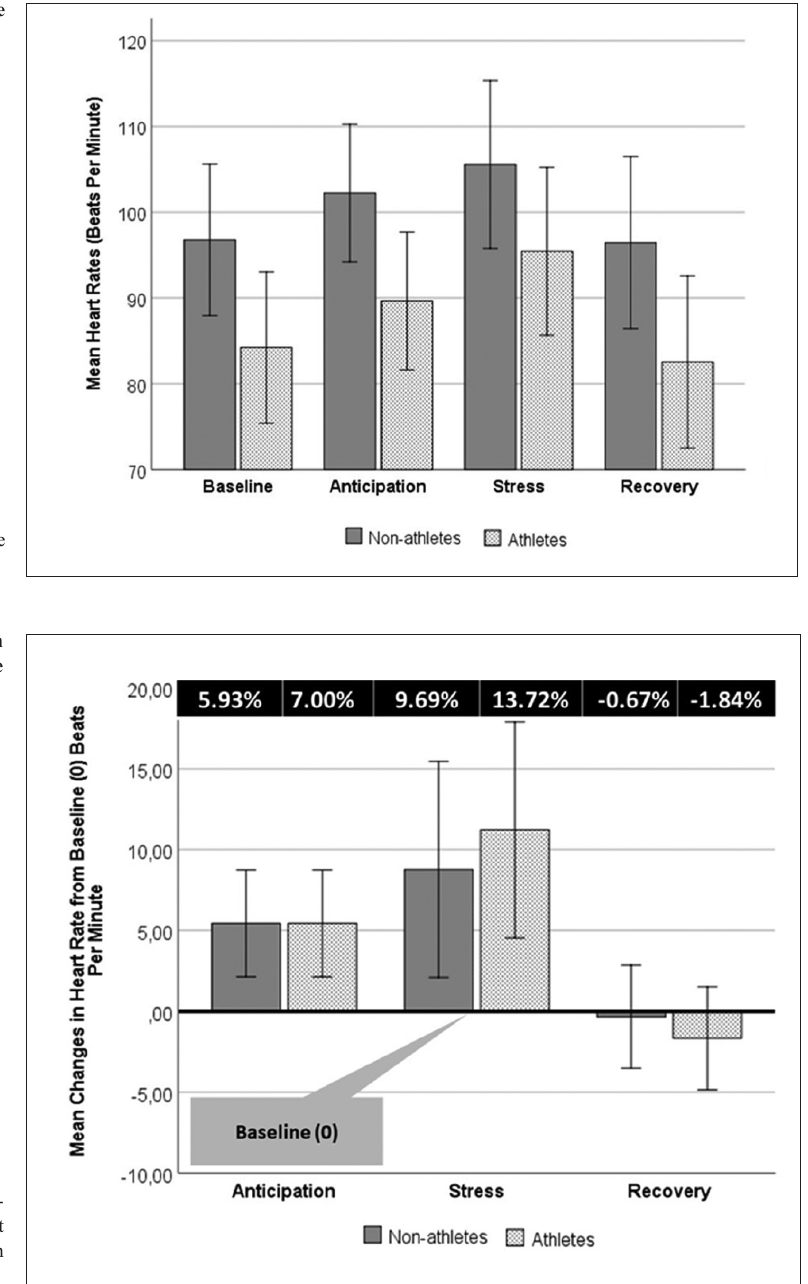
Figure 2. Heart rates at baseline and in three phases of stress exposure